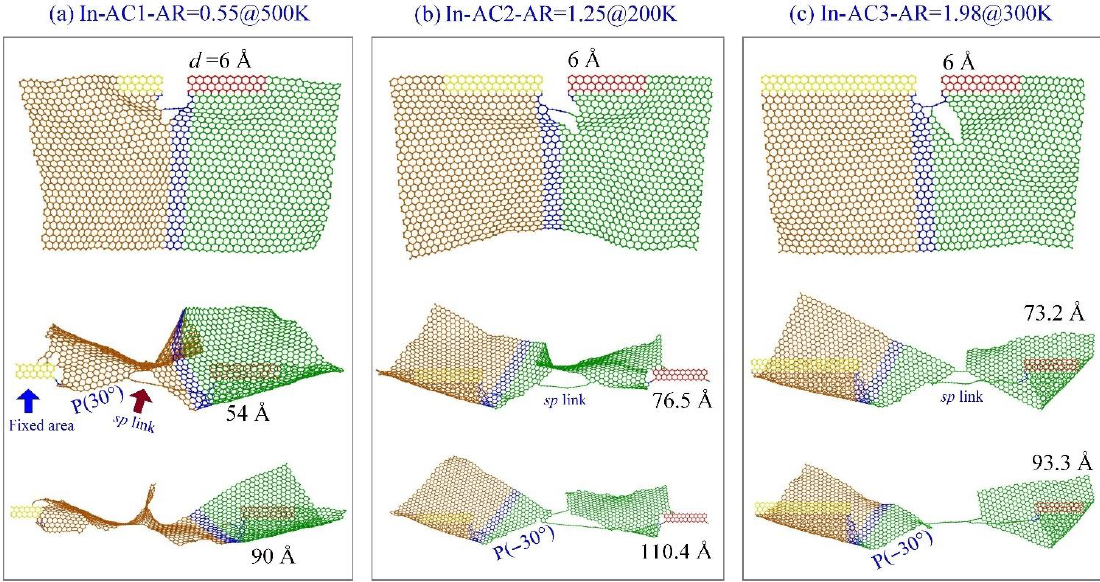
Figure 9. Snapshots of graphene sheets with different values of AR in an in-plane tearing with v = 0.6 Å /ps at different temperatures, e.g., ( a ) In-AC1 at 500 K, ( b ) In-AC2 at 200 K, ( c ) In-AC3 at 300 K.